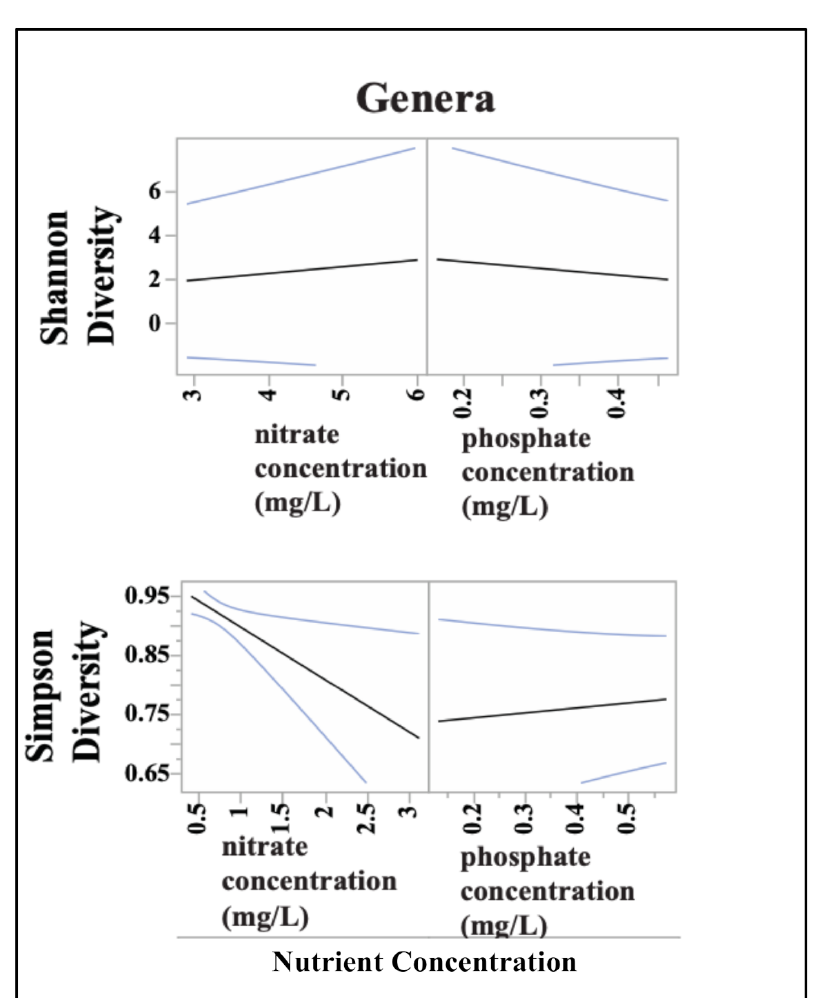
Figure 6. Prediction profiles from ANOVA, showing the effect of measured nitrate and phosphate concentration (mg/L) on the Shannon and Simpson diversity indices identified as taxonomic genera out of wetland sites 1–6 during summer 2017. The blue-lined area in each profile represents the 95% confidence prediction interval of the response variable. The profiler was set for nitrate at 2.72 mg/L and phosphate at 0.49 mg/L in the case of Shannon diversity, and nitrate at 2.60 mg/L and phosphate at 0.32 mg/L in the case of Simpson